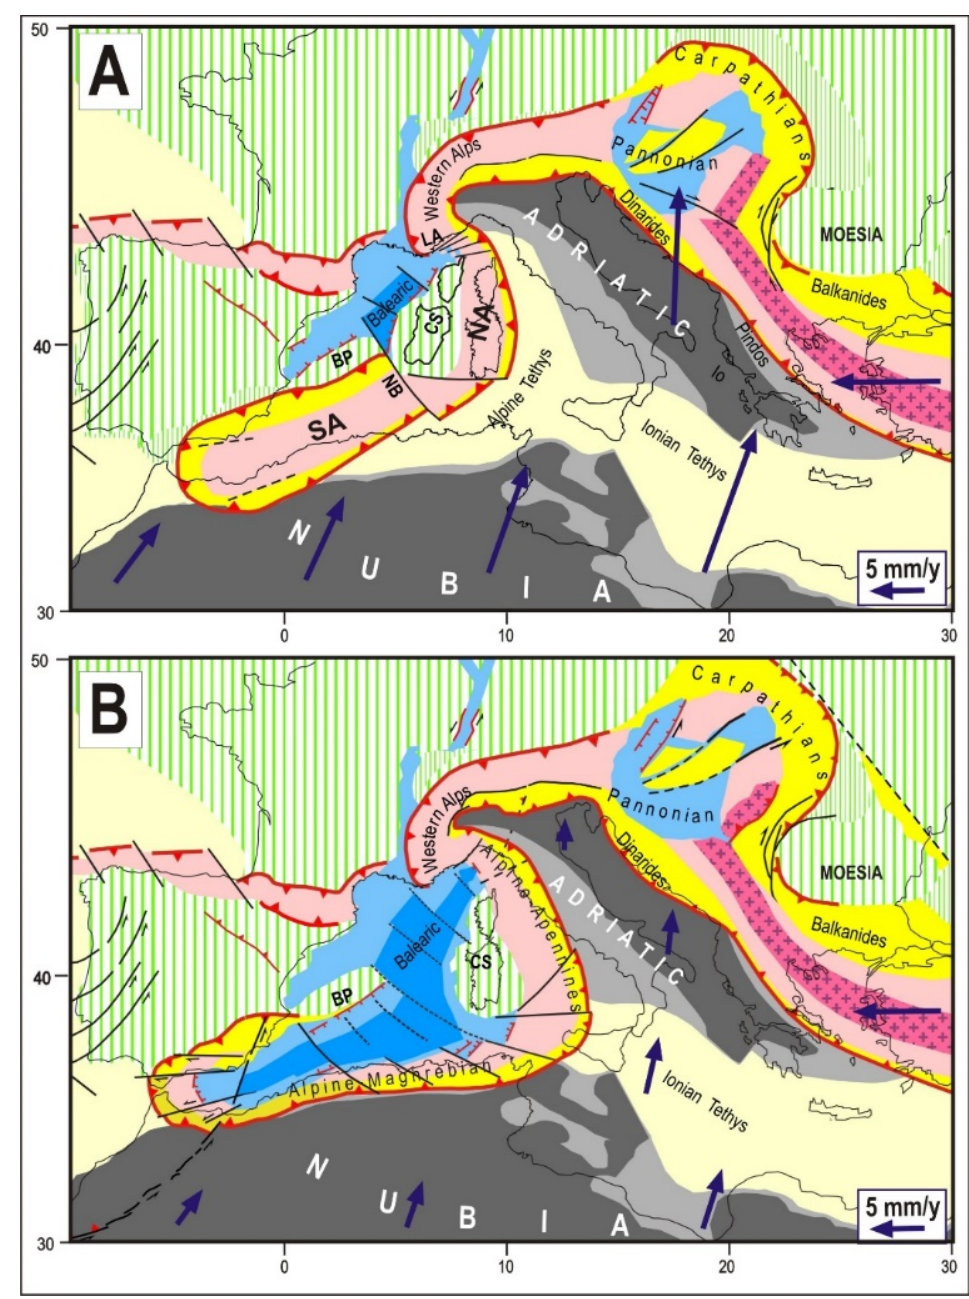
Figure 4. ( A ) Early Miocene. The Northern Arc (NA, Alpine–Iberian–Apennine belt) underwent a greater rotation with respect to the Southern Arc (SA, Alpine–Iberian–Maghrebian belt), allowed by the North Balearic dextral shear zone (NB). BP = Balearic Promontory, CS = Corsica-Sardinia, Io = Ionian thinned continental zone, LA = Ligurian Alps. ( B ) Middle–Late Miocene . After long migration and considerable bending (induced by the Nubia–Eurasia convergence) the Arc reached a configuration with two almost perpendicular segments. The Corsica-Sardinia block reached its final location, after the collision of the Northern Arc with the Adriatic continental domain (Middle Miocene). The Southern Arc stopped its migration against the continental Nubian domain (Upper Miocene). Colours and symbols as in Figure 1.